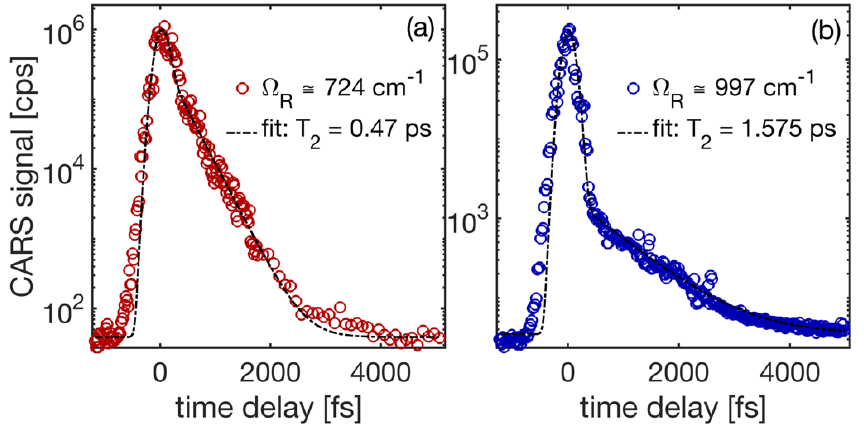
Figure 4. CARS transients obtained from KTiOPO 4 crystal while exciting and probing closely spaced strong ( a ) and weak ( b ) lattice vibration modes within the Ti-O octahedron of the crystal’s elementary lattice unit. The OPO 1 central wavelength was fixed at ~1015 nm, while the OPO 2 wavelengths have been tuned to ~1097 nm and ~1136 nm, correspondingly, to facilitate the phonon excitations. The phonon decay time constant values T 2 , indicated in the legend, are obtained from the best-fitting results (dash-dotted